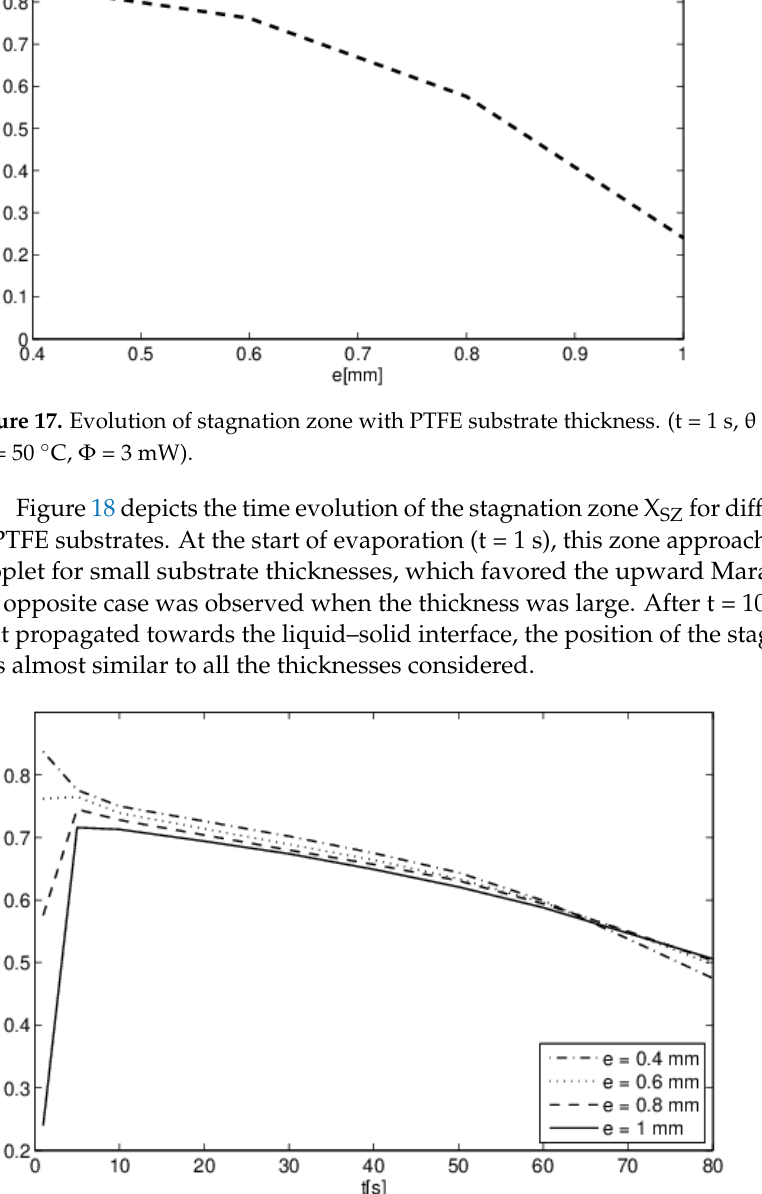
Figure 18. Temporal evolution of stagnation zone for PTFE substrate thickness. (T h = 50 °C, Φ = 3